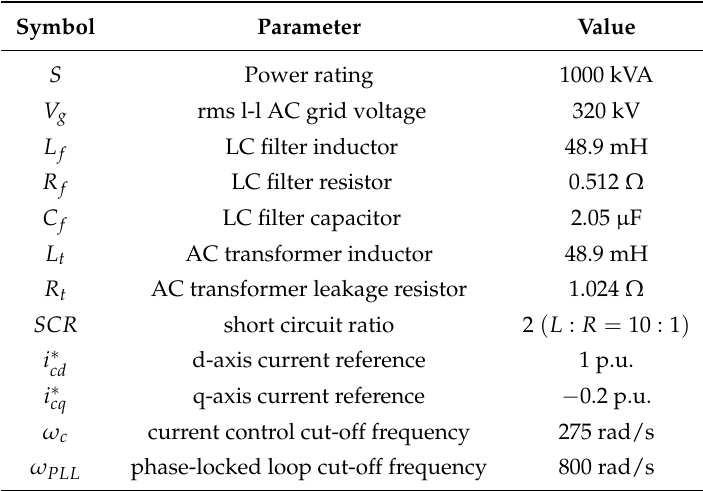
Figure 3. Pole locus: determinant-based impedance stability analysis vs. state-space stability analysis. Table 1. Parameters of the grid-connected